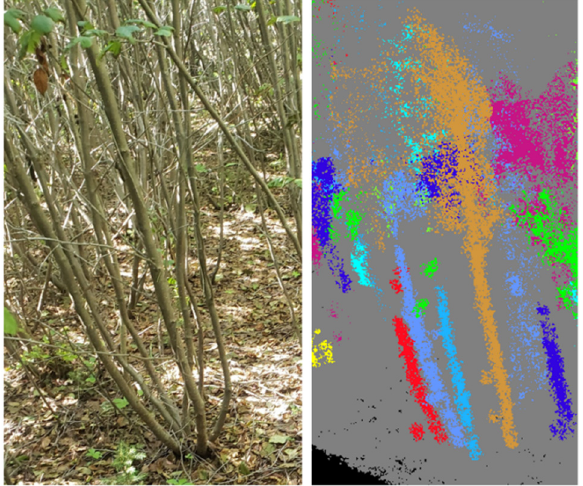
Figure 5. A tall (> 1.3 m), multi-stemmed Alnus viridis individual; the left is a photo showing its base and stems on a seismic line measured this study, and the right is a clip of a similarly sized A. viridis plant from LiDAR 360 following point cloud segmentation where each colour indicates an individual “tree” stem identified by the CSP algorithm.